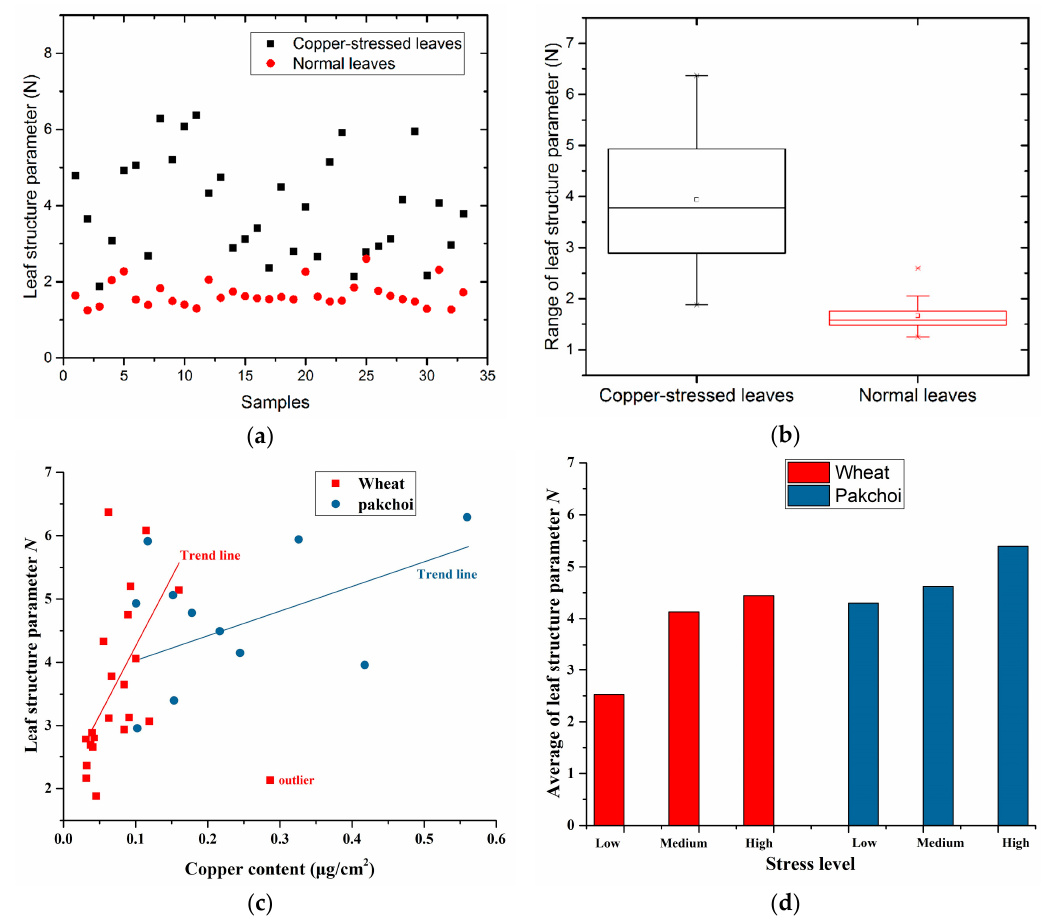
Figure 5. Leaf structure parameters N of copper-stressed leaves and normal leaves: ( a ) The value of leaf structure parameters; ( b ) The box-and-whisker plots of leaf structure parameters; ( c ) Leaf structure parameters vs. leaf copper content with different symbols for each species; ( d ) Bar graphs for the average of different stress levels (low, medium, high) and species.